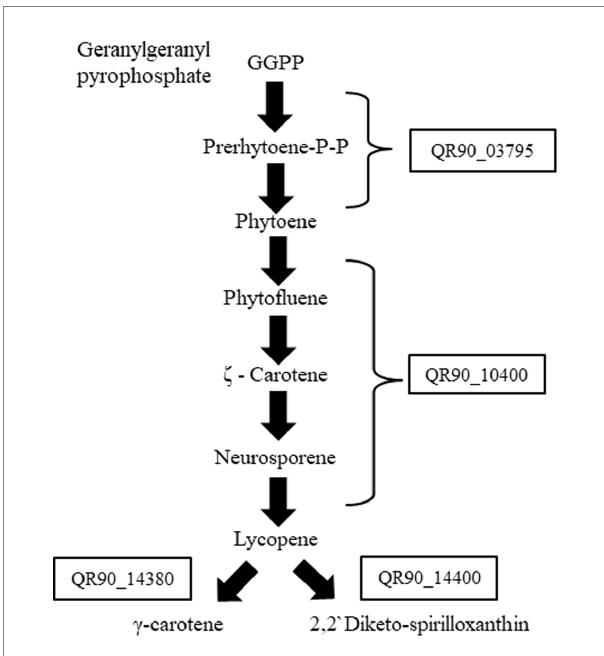
FIGURE 2 Simplified schematic of the carotenoid biosynthesis pathway in DY59 strain from KEGG carotenoid pathway